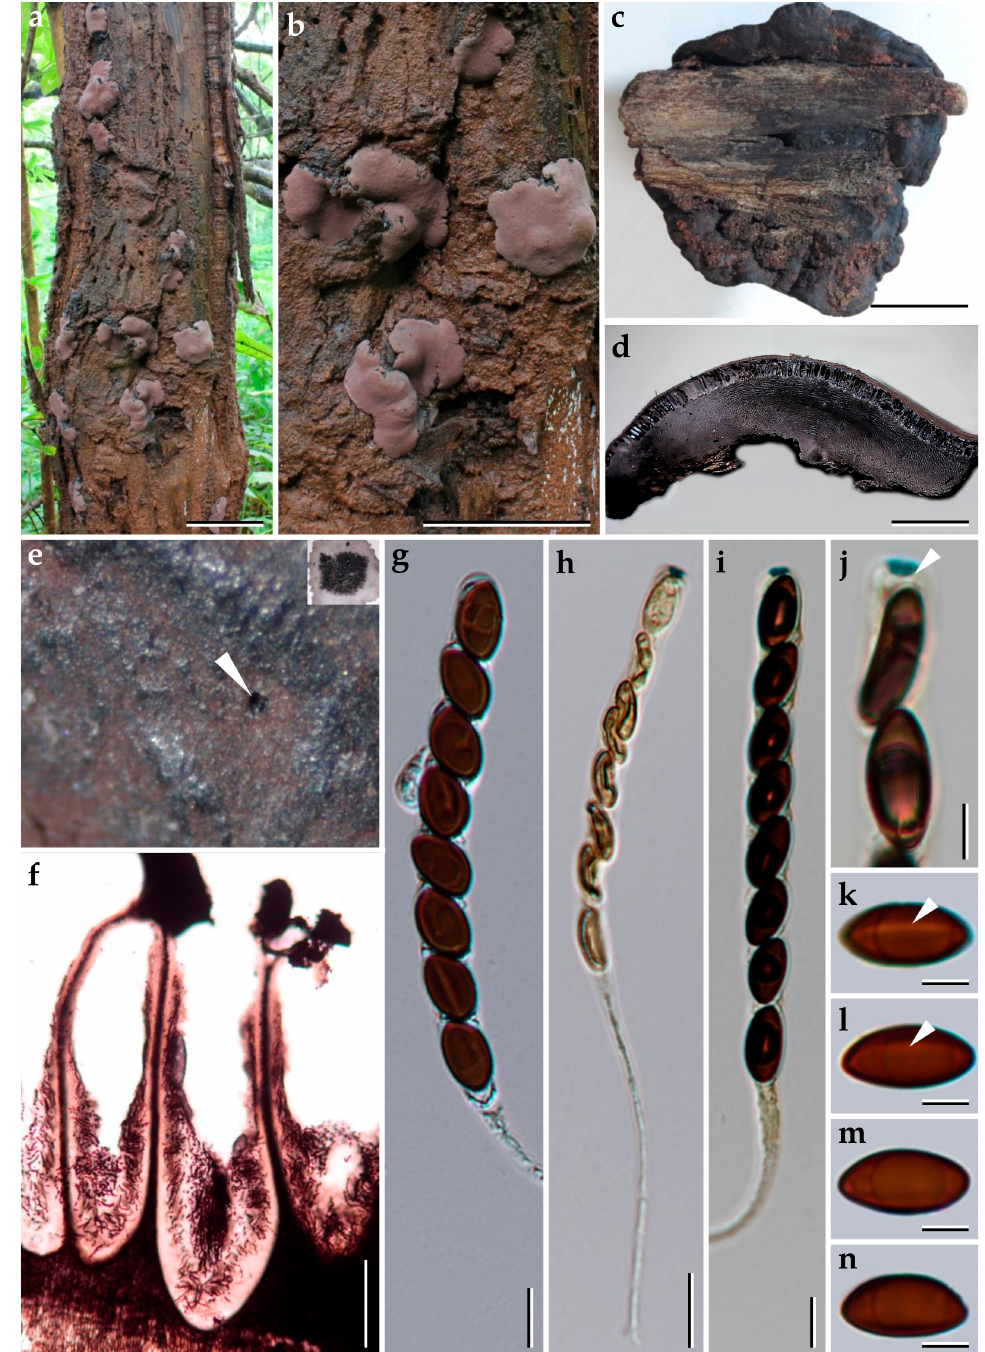
Figure 6. Morphological characteristics of Pyrenopolyporus cinereopigmentosus (BBH47927). ( a , b ) Stromata on natural habitat; ( c ) stromata showing ventral surface. ( d ) Longitudinal section of the stroma showing the tissue below the perithecial layer; ( e ) stromatal surface showing ostioles (white arrow) with KOH-extractable pigment; ( f ) longitudinal section of the stromata showing perithecia under light microscope; ( g – i ) asci. ( j ) Apical apparatus bluing in Melzer’s reagent (white arrow); ( k , l ) ascospores showing germ slit (white arrow); ( m , n ) ascospores. Scale bars ( a , b ) = 5 cm; ( c ) = 1 cm; ( d ) = 5 mm; ( f ) = 0.25 mm; ( g – l ) = 10 µm; ( j – n ) = 5 µm.